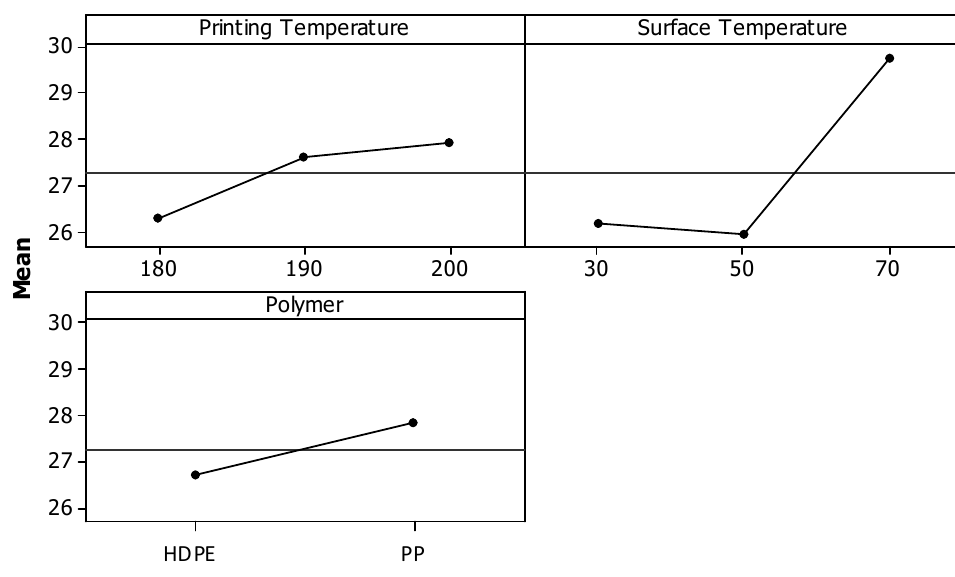
Figure 4. Mian effects plot for tensile strength.